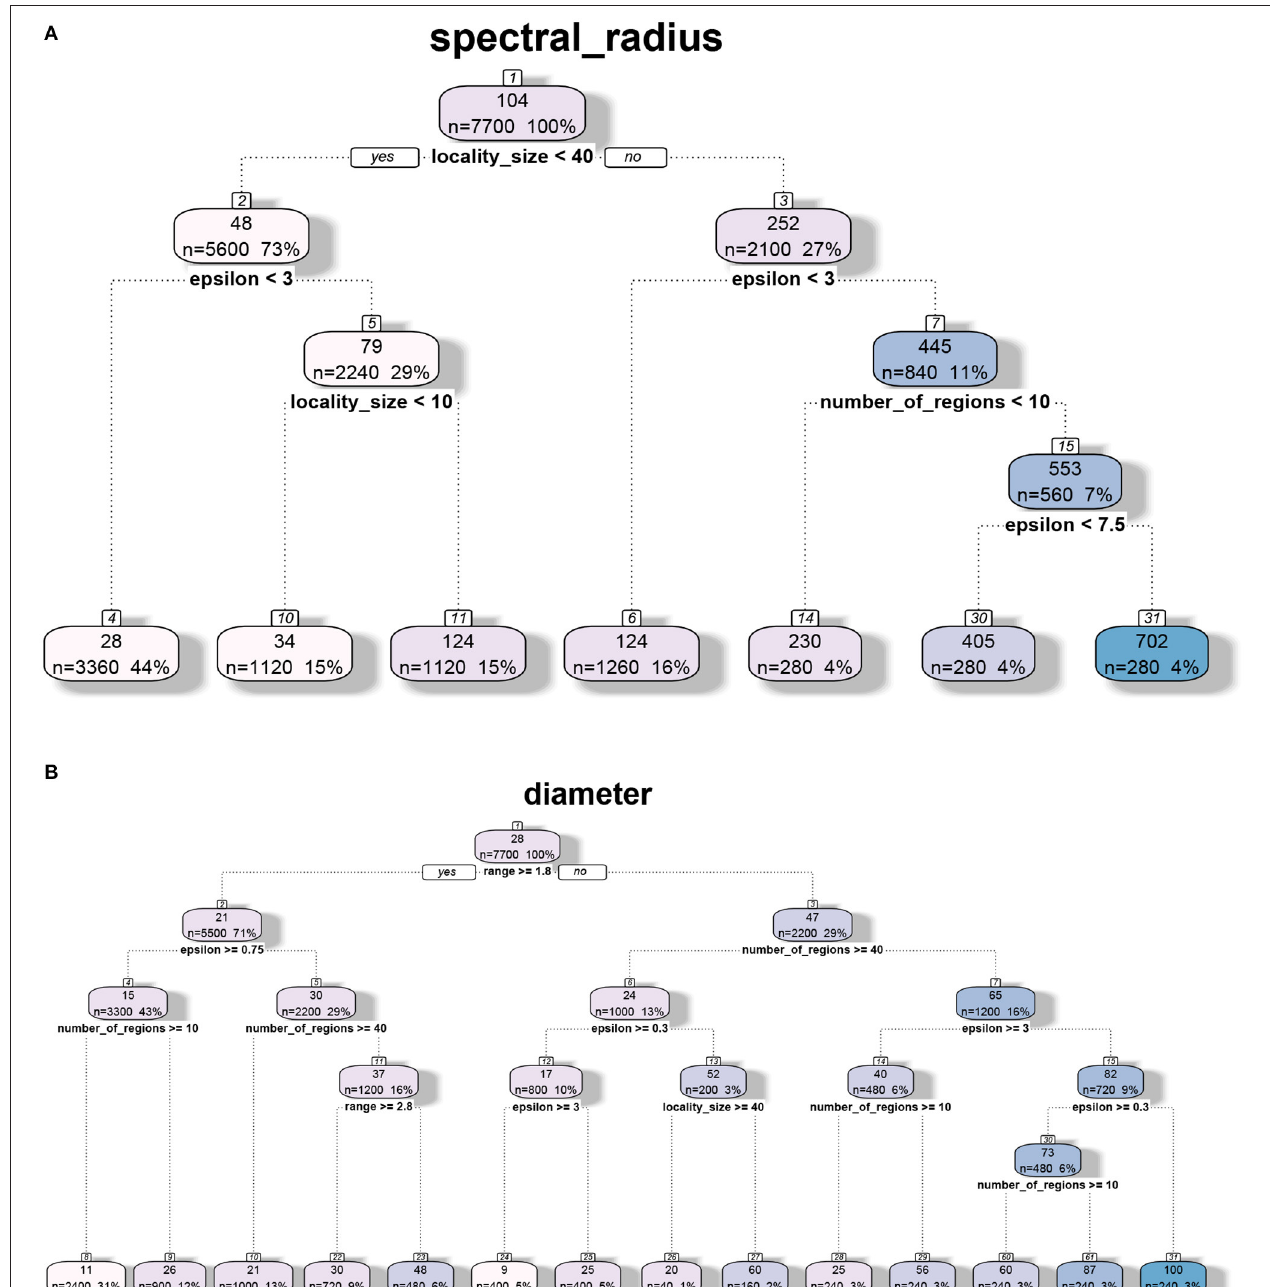
FIGURE 3 | Regression tree analysis of network properties with respect to model parameters for the MPSN model. The properties were computed for various networks given in Table 1 . (A) CART analysis: Spectral radius λ 1(G). (B) CART analysis: Diameter diam (G).